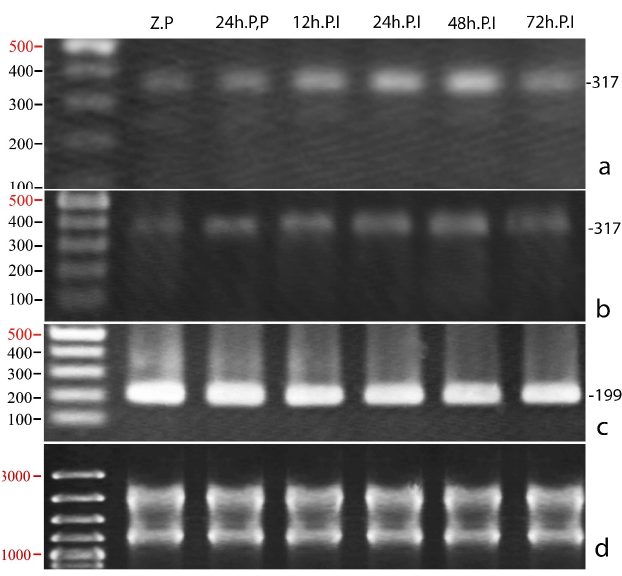
Fig. 6: PR 1 gene expression after inoculation. Effect of BABA treatment on the expression of PR 1 during of disease development by P. xanthii. (a); PR 1 gene expression pattern on infected and BABA-primed (4 mM) cucurbit plants. (b); PR 1 gene expression pattern on not infected control cucurbit plants. (c); Balanced 18SrRNA expression after 35 cycle of PCR. (d); Balanced total RNA. Z.P; time point 0. 24 P.P; 24 h post priming. 12hpI, 24hpI, 48hpI and 72hpI; hours post inoculation.